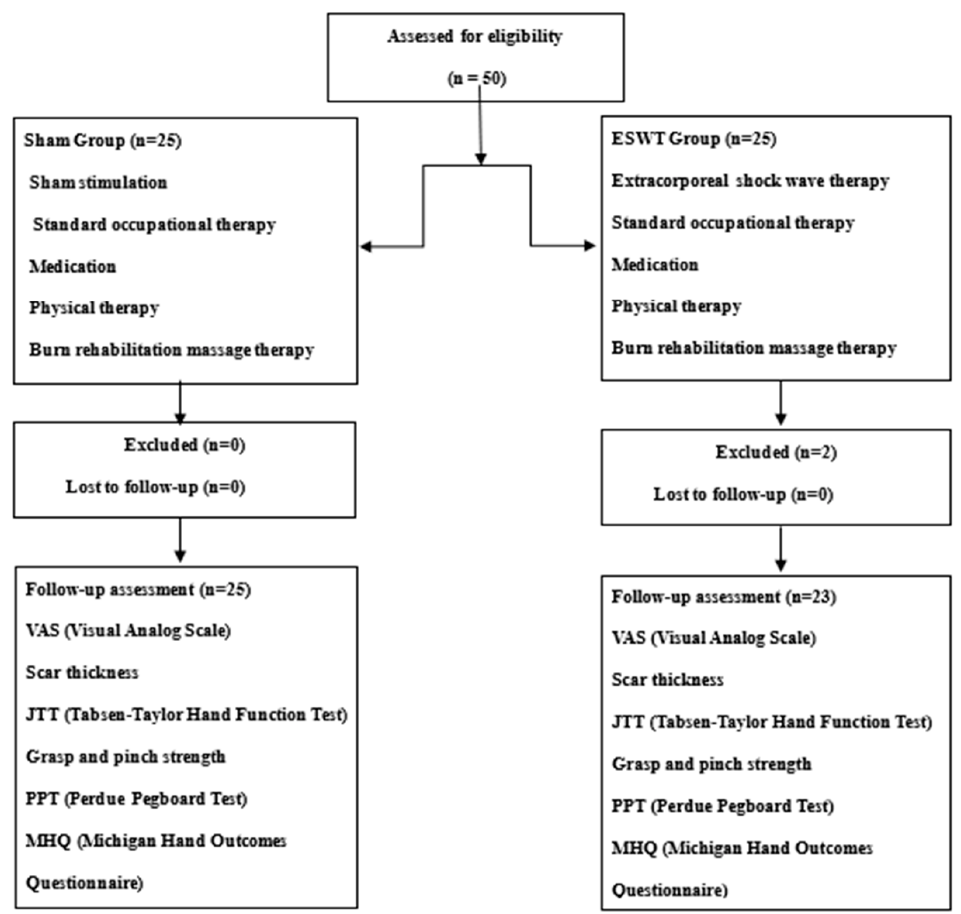
Figure 1. Diagram for subject enrollment, allocation, and